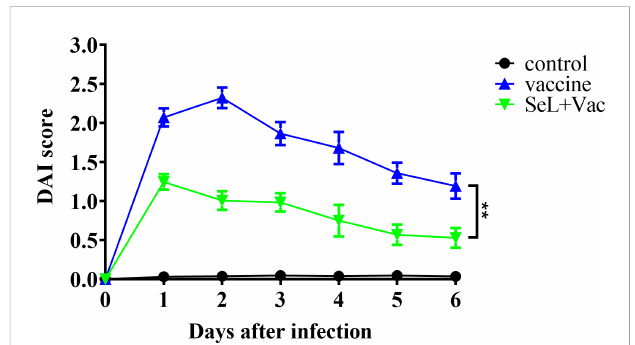
challenge. The clinical symptoms of rabbits were watched and recorded on days 0 – 6 after challenge. The results were expressed as DAI score. Each experimental group consisted of fi ve rabbits per group. Data were presented as means ± SD (**P < 0.01). The statistical analysis was performed using two-way ANOVA.